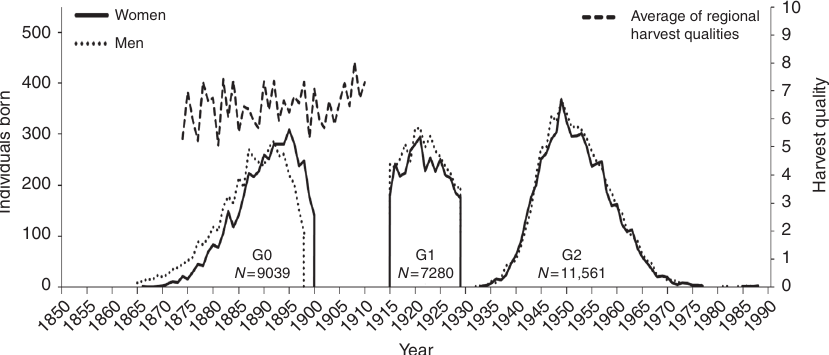
Fig. 1 Three linked generations. Birth year distribution of G0, G1 and G2 by gender (number of individuals born each year; left Y -axis) and annual average harvest quality for years 1874 – 1910 (right Y -axis), which period corresponds to G0 slow